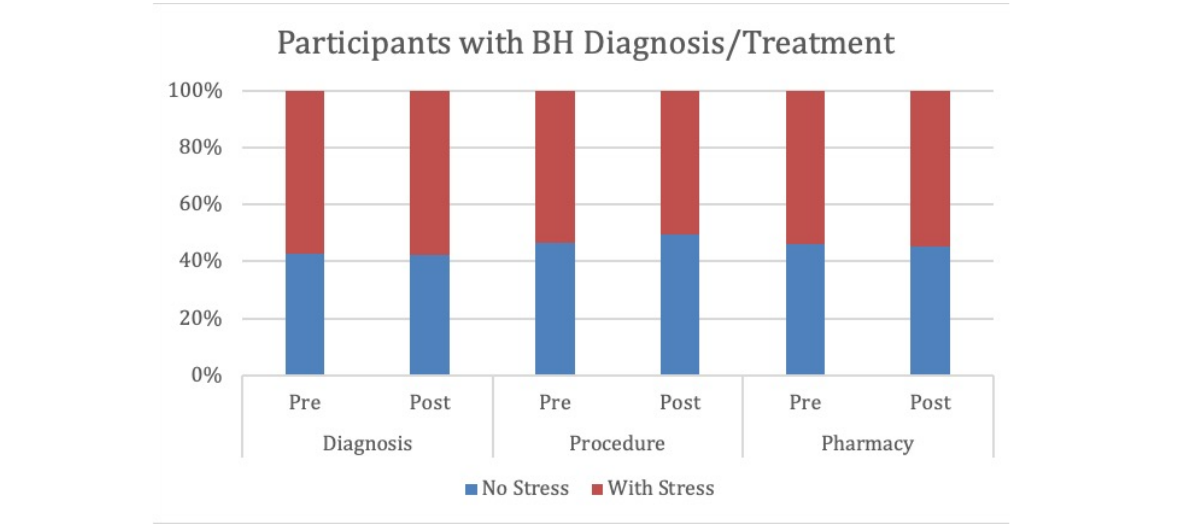
Figure 1. Participants with behavioral health diagnosis/treatment. BH: Behavioral health; Pre: 12 months prior to the study index date; Post: 12